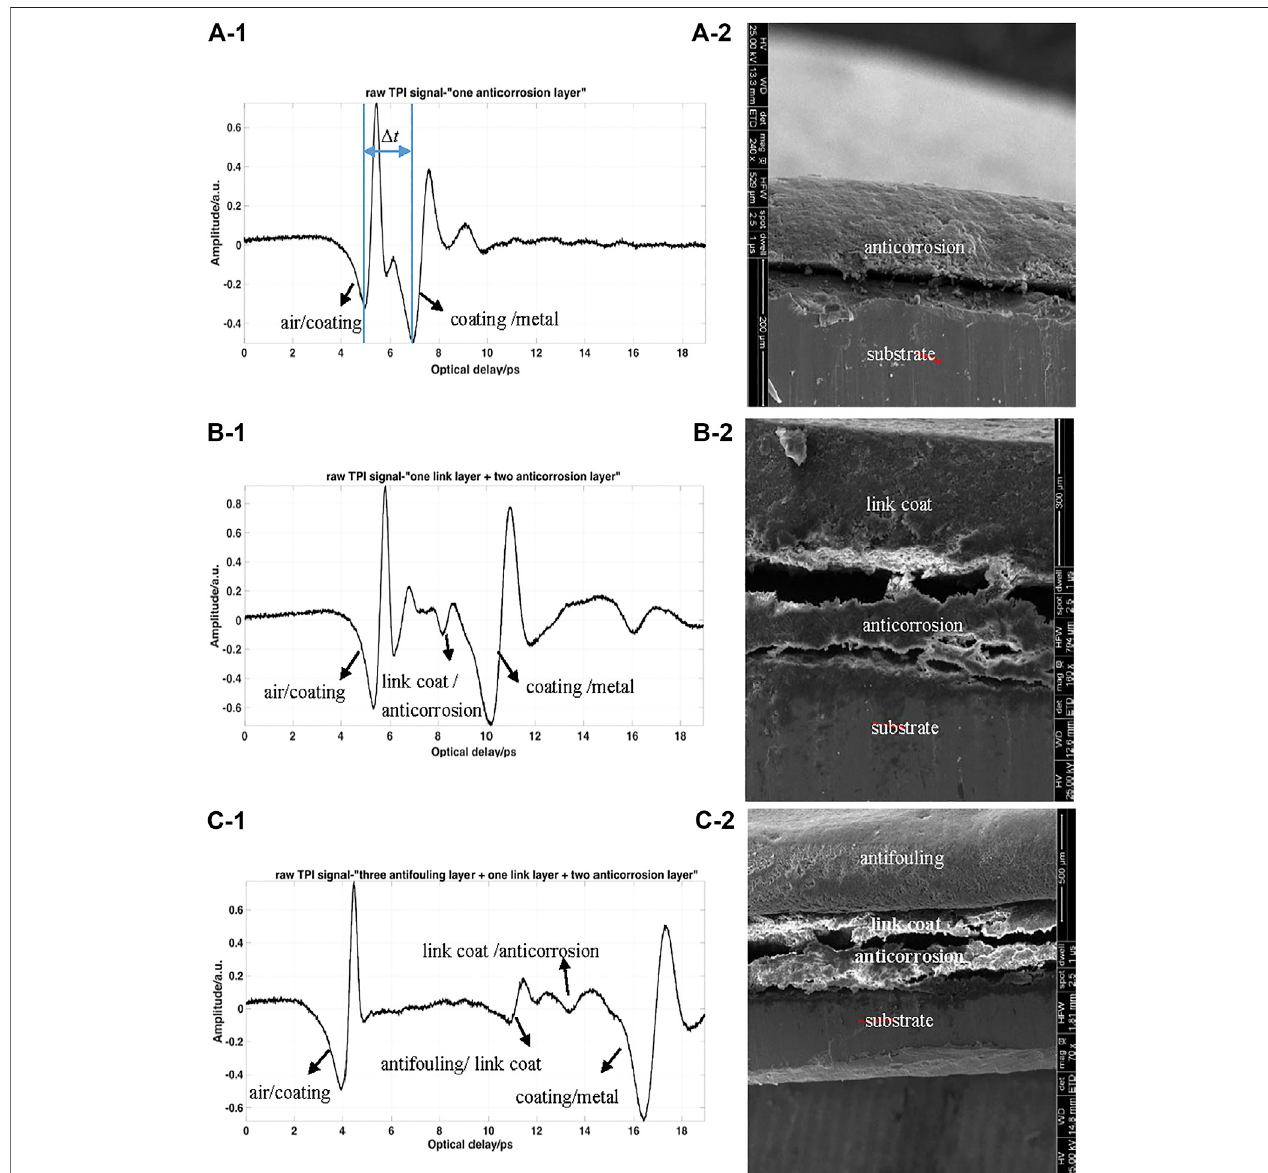
FIGURE 2 | TPI signal and SEM scan results of various coated samples (Ai) , (Aii) Sample 4; (Bi) , (Bii) Sample 5; (Ci) , (Cii) Sample 6.